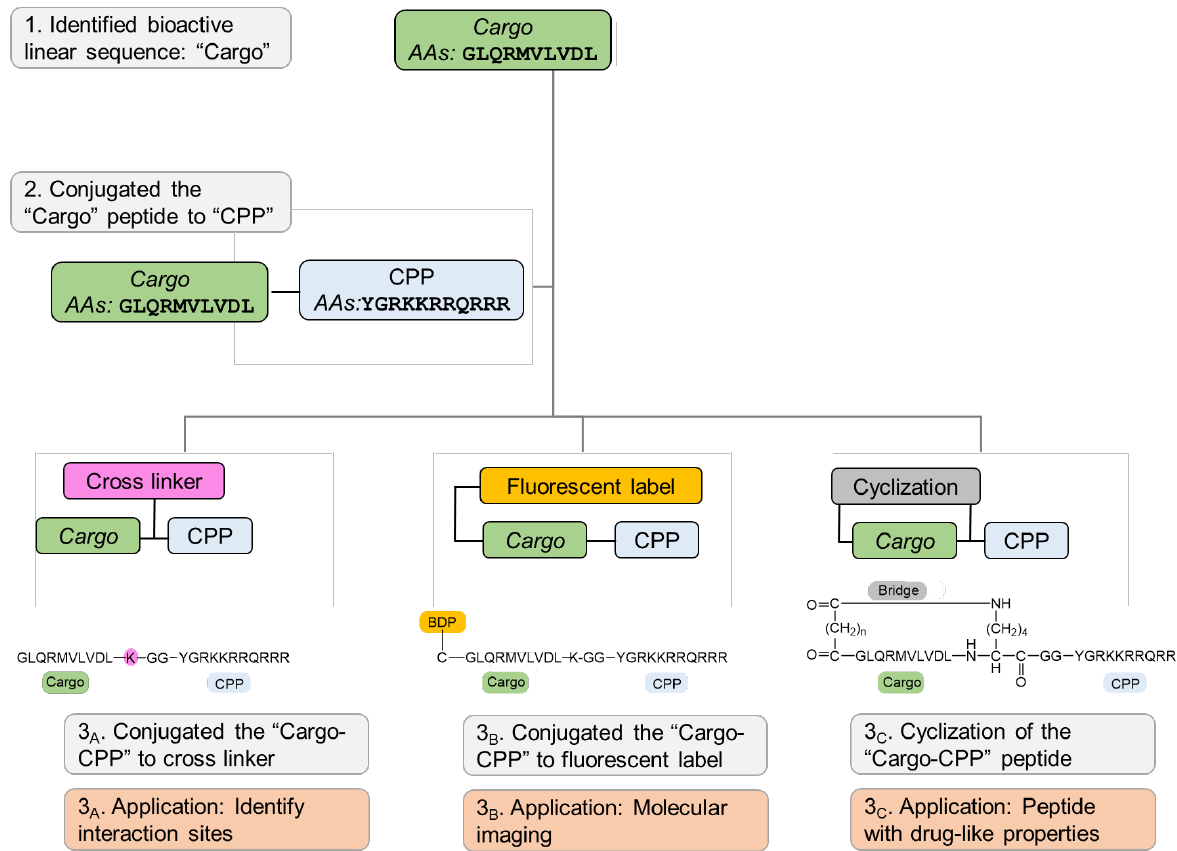
Figure 8. Schematic diagram of converting a bioactive linear peptide sequence into advanced research tools and potential therapeutic.